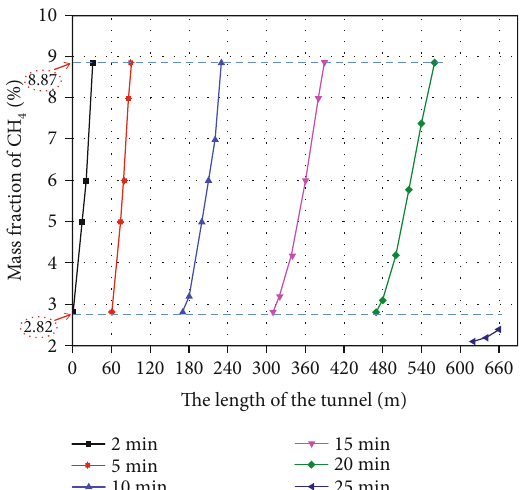
Figure 12: CH explosion cloud distribution in the tunnel (Case 1). 4